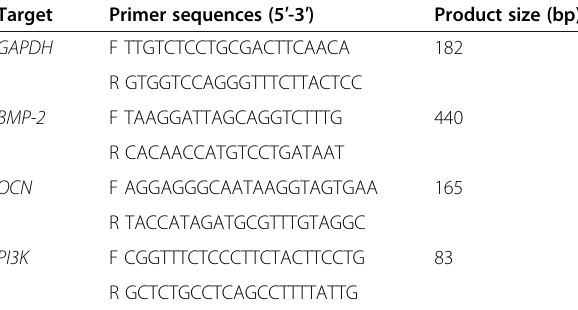
Table 1 Polymerase chain reaction primer